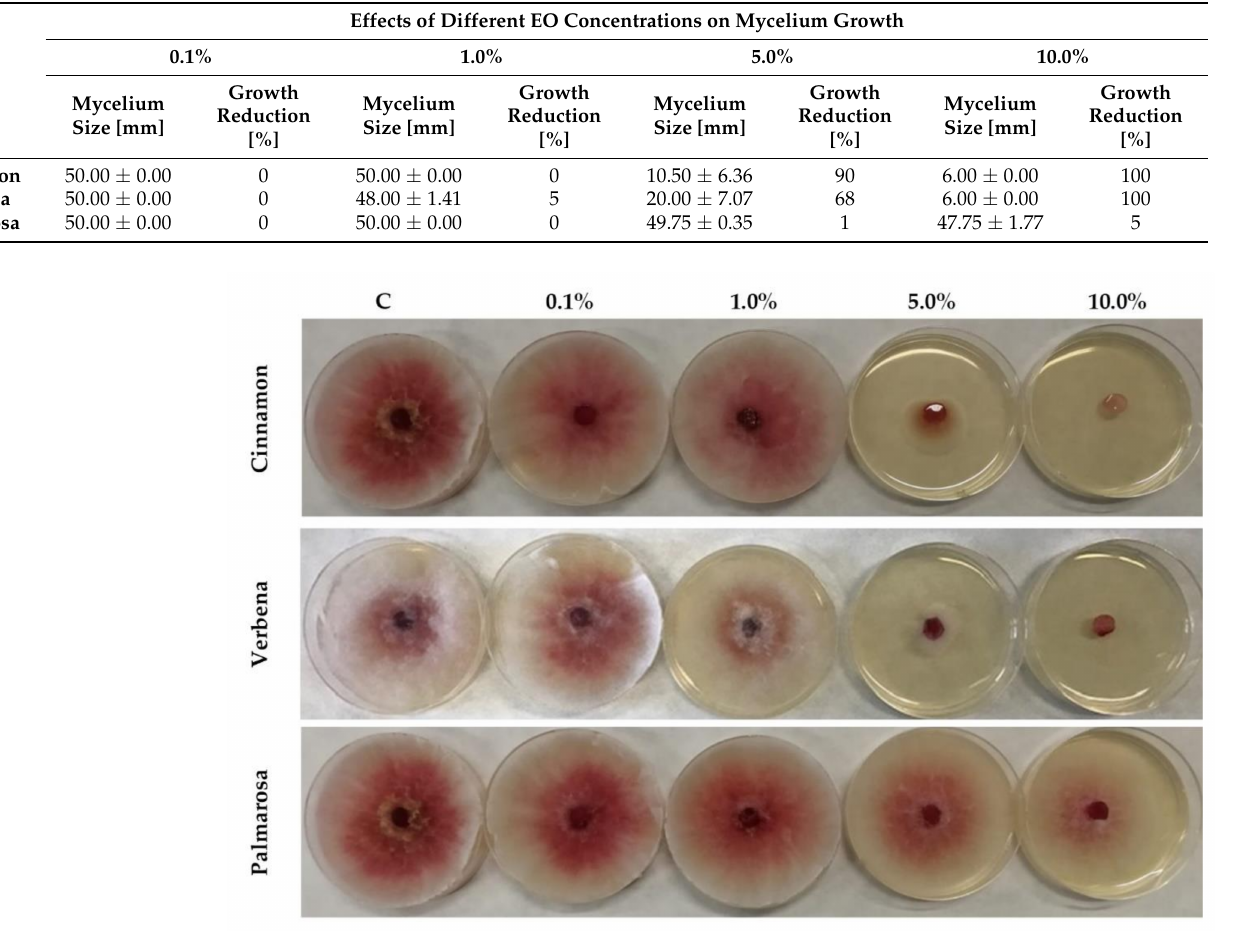
Figure 1. Volatile effects of different concentrations of palmarosa, verbena and cinnamon EOs on the mycelial growth of F. graminearum on PDA medium (C–control; EO tested concentrations: 0.1%; 1.0%; 5.0%;